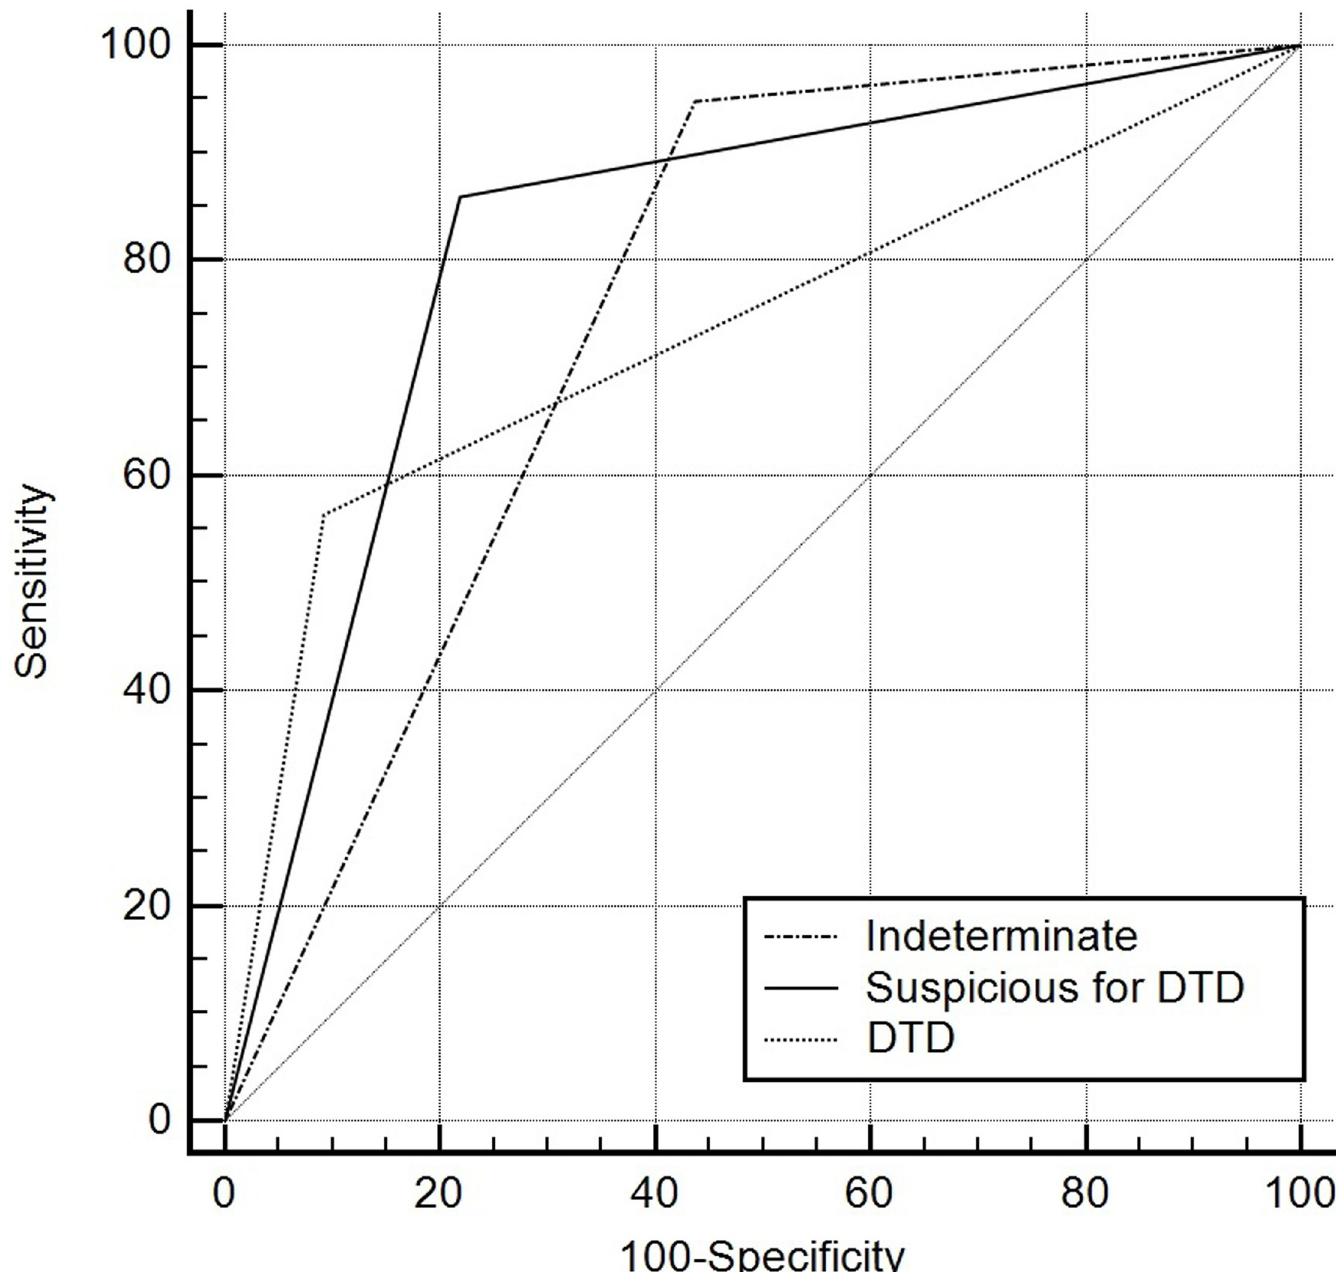
Fig 3. Comparisons of the receiver operating characteristic (ROC) analyses for the diagnostic accuracy of the cut-off computed tomography category to differentiate diffuse thyroid disease from normal thyroid parenchyma. Diagonal line = 50% of the area under the ROC curve; also refers to a hypothetical marker that has no discriminatory power for differentiating diffuse thyroid disease from normal thyroid